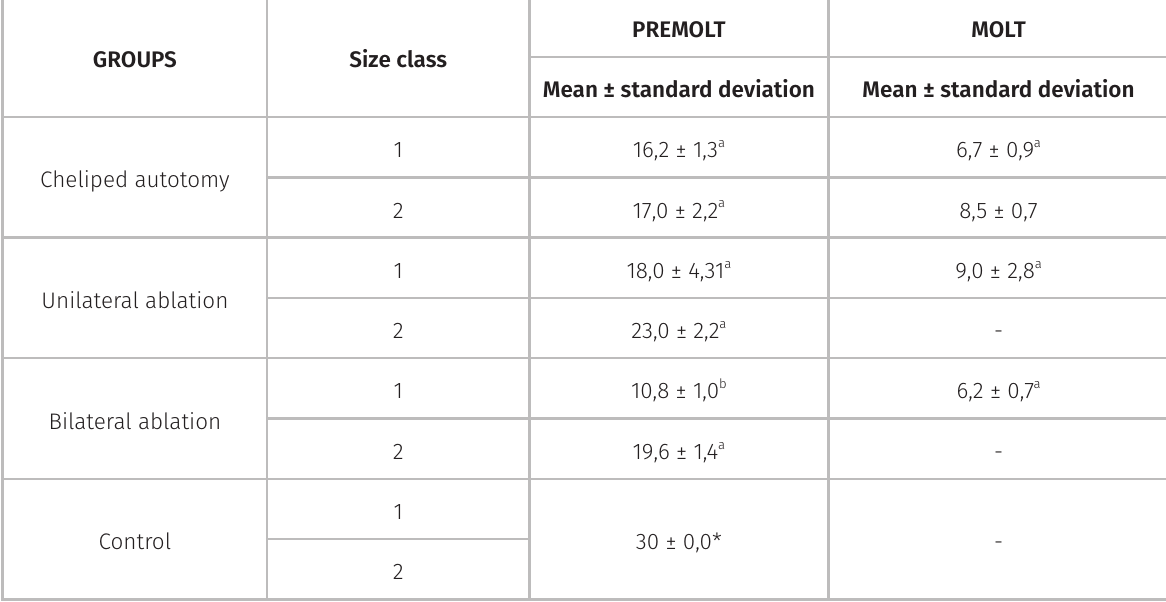
Table III. Time (days) until the premolt stage and, subsequently, until molting in Callinectes ornatus specimens subjected to different experimental